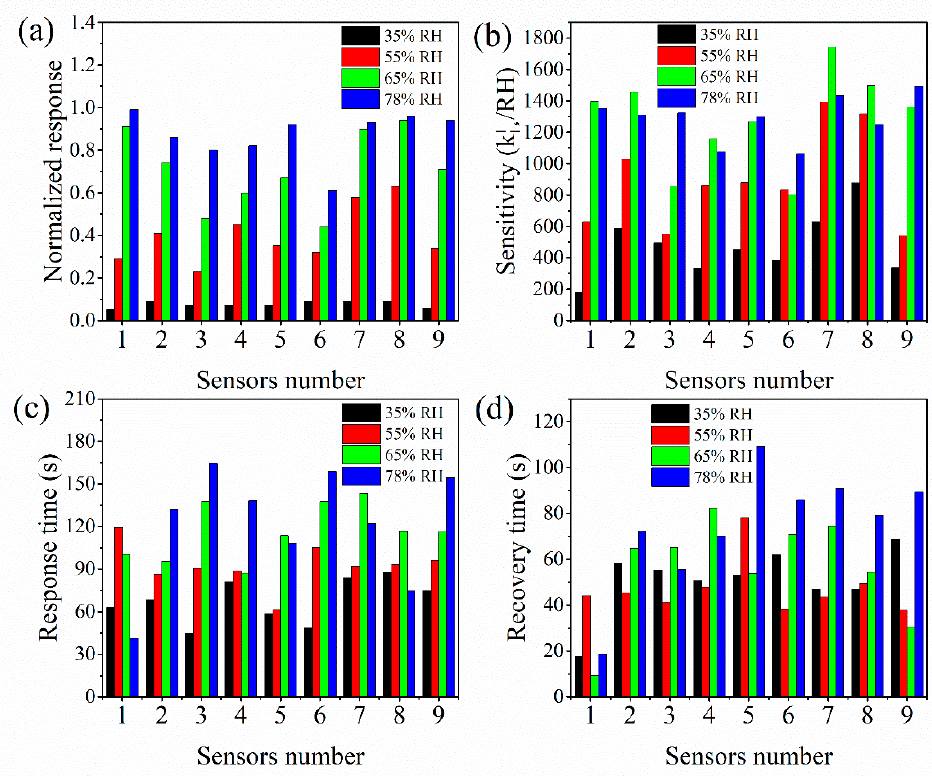
Figure 7. Sensing characteristics of humidity sensor in various humidities: ( a ) normalized response; ( b ) sensitivity; ( c ) response time; ( d ) recovery time.